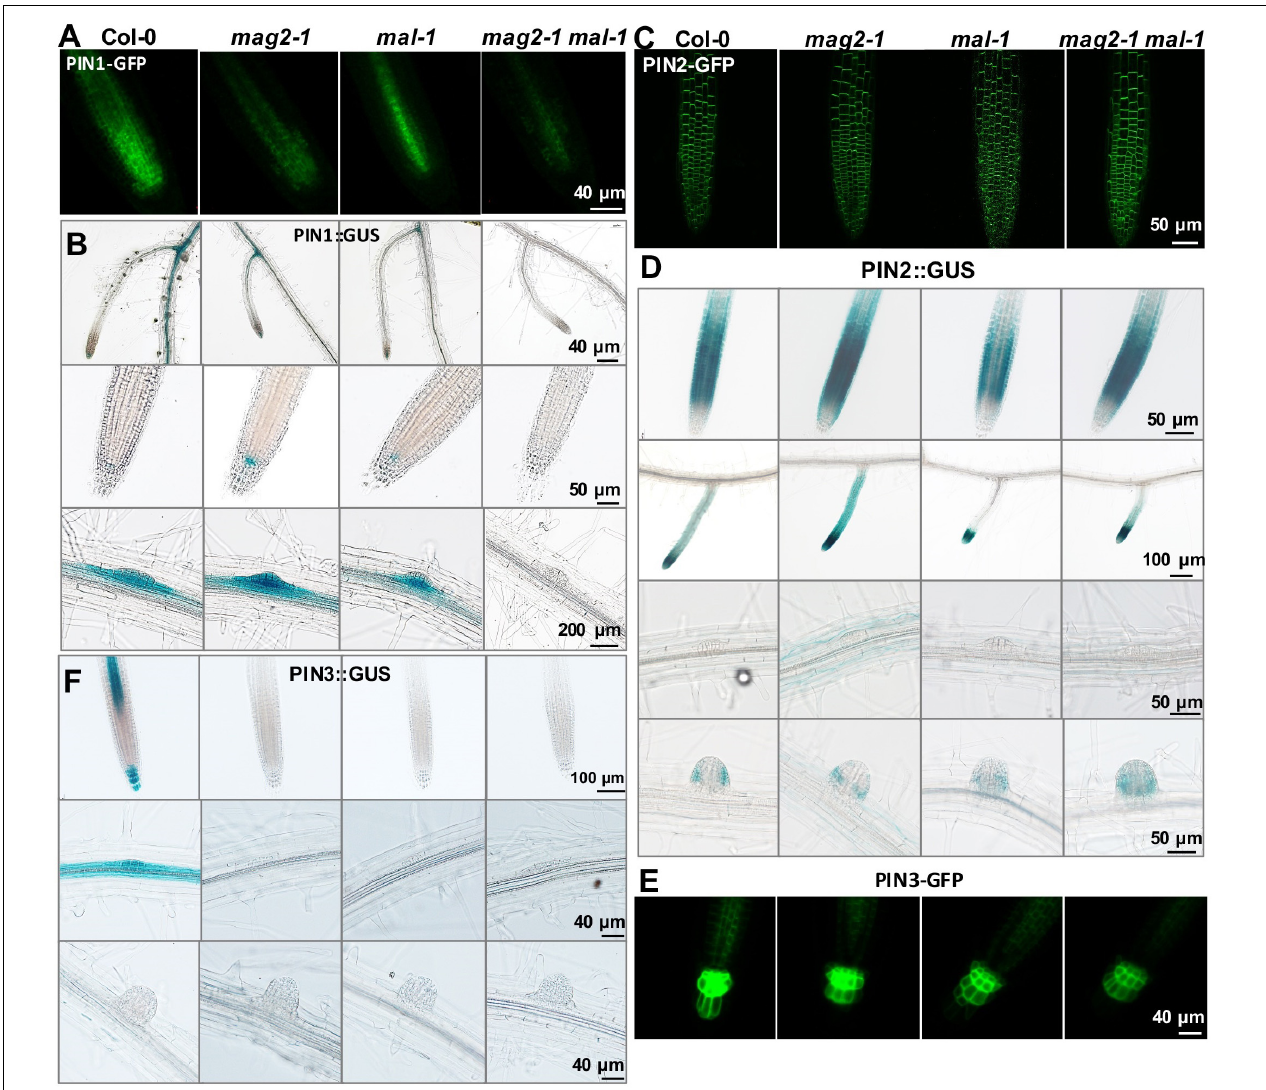
FIGURE 7 | MAG2 and MAL regulate the expression of auxin transporters. Confocal images of (A) PIN1-GFP, (C) PIN2-GFP, and (E) PIN3-GFP in primary roots. (B,D,F) Expression pattern of (B) PIN1:GUS, (D) PIN2:GUS, and (F) PIN3:GUS in 7-day-old seedlings grown in 1/2MS medium tissues. Bars are as shown.